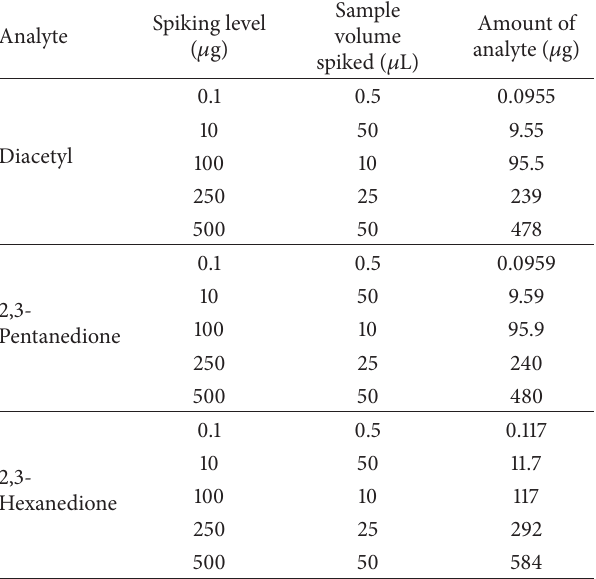
Table 1: Preparation of analyte stock solutions and spiking volumes for recovery